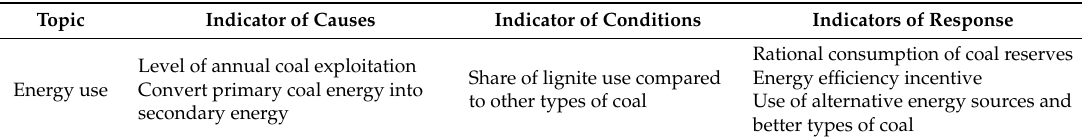
Table 1. Indicators of coal